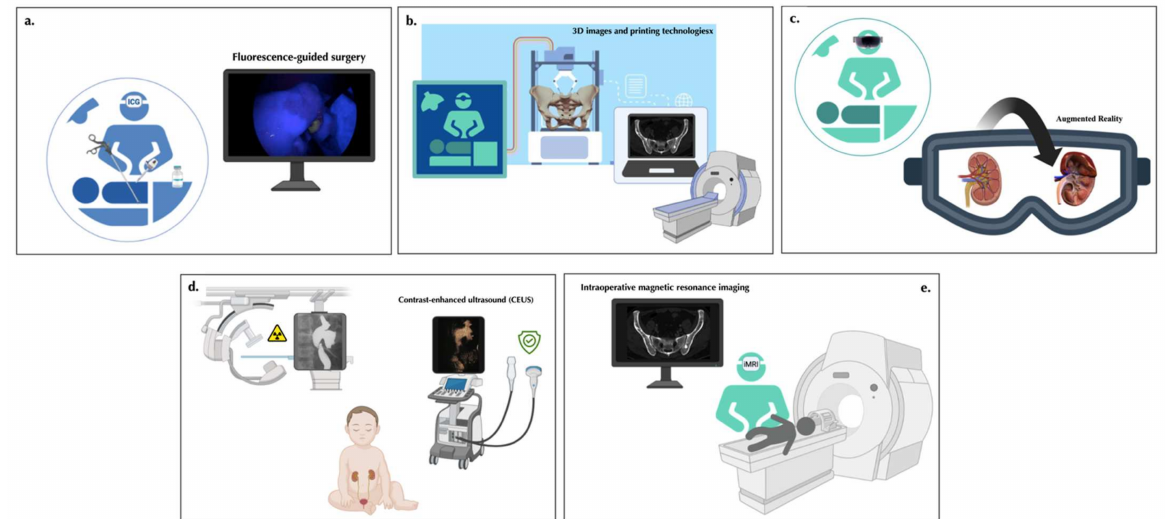
Figure 1. Schematic view of the novel innovative technologies for improved visualization in the field of pediatric urology described in this narrative review, including ( a ), indocyanine green (ICG)- based Fluorescence-guided surgery (FGS), ( b ) three-dimensional (3D) reconstructions and printing technologies, ( c ) Augmented reality, ( d ) Contrast-enhanced ultrasound (CEUS), and ( e ) intraoperative Intraoperative magnetic resonance imaging